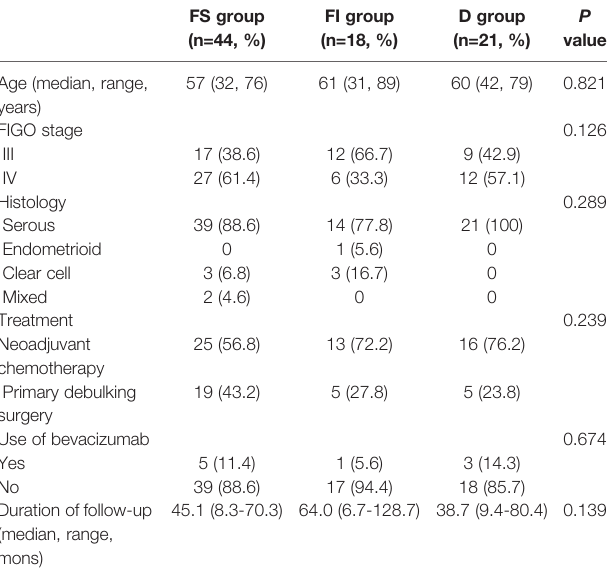
TABLE 1 | Clinicopathologic